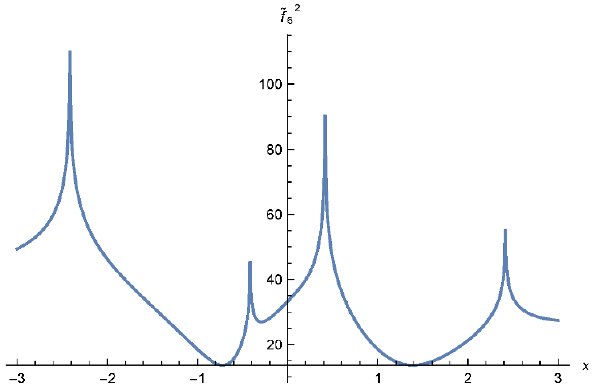
Figure 2 . The function ~ f 2 = j N j , evaluated on the boundary of (cid:6) for the symmetric four external 6 brane background of (3.8). Note the global minima at x = (cid:6) 1, as well as the divergence at each of the poles.